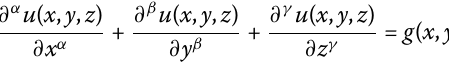
| | ∂ u ∂ u y =1 = z =1 = 0. The analytical solution of this problem is u ( x , y , z ) = xyz (2– x )(2– y ∂ y ∂ z